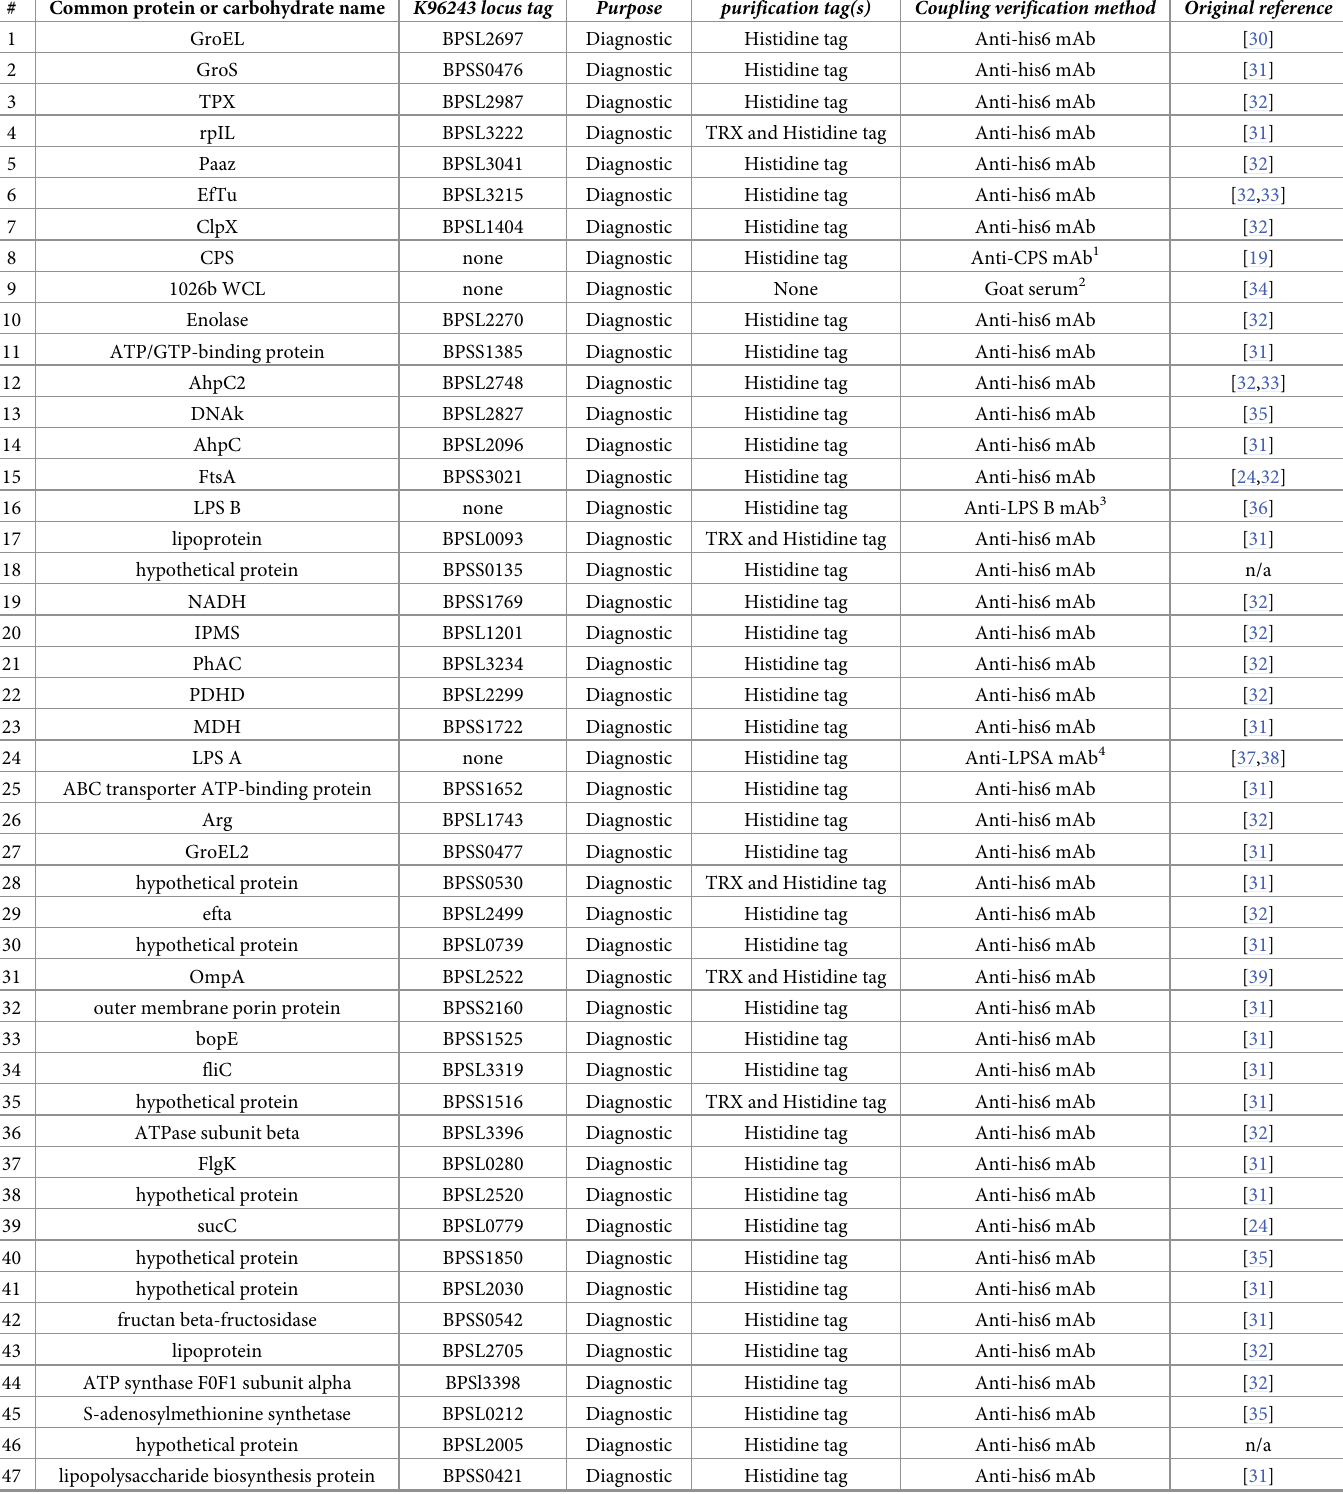
Table 1. Purified antigens coupled to bead regions and the associated